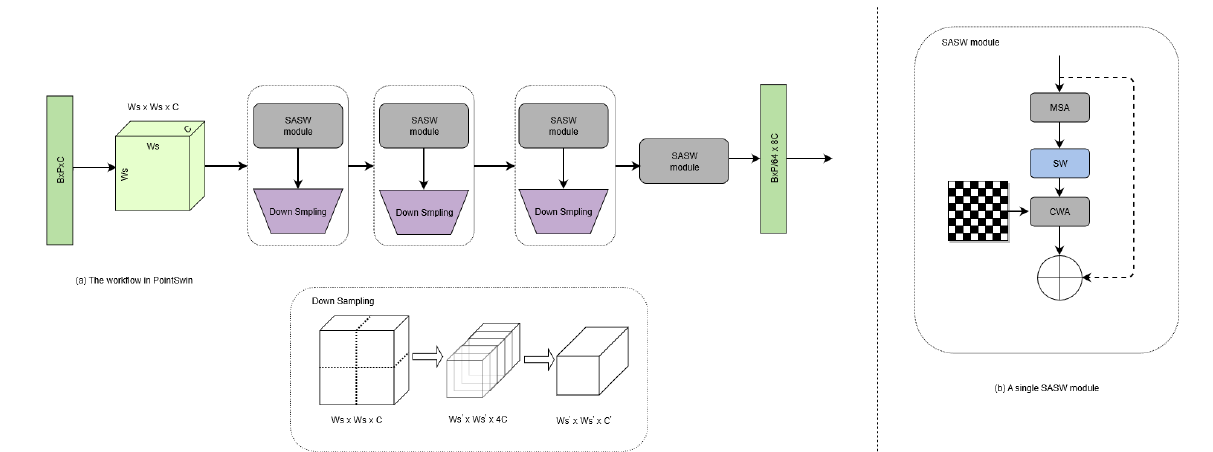
Figure 1. ( a ) The overall workflow diagram of the Self-Attention with Shifted-Window part in PointSwin; ( b ) The workflow of a single SASW block.